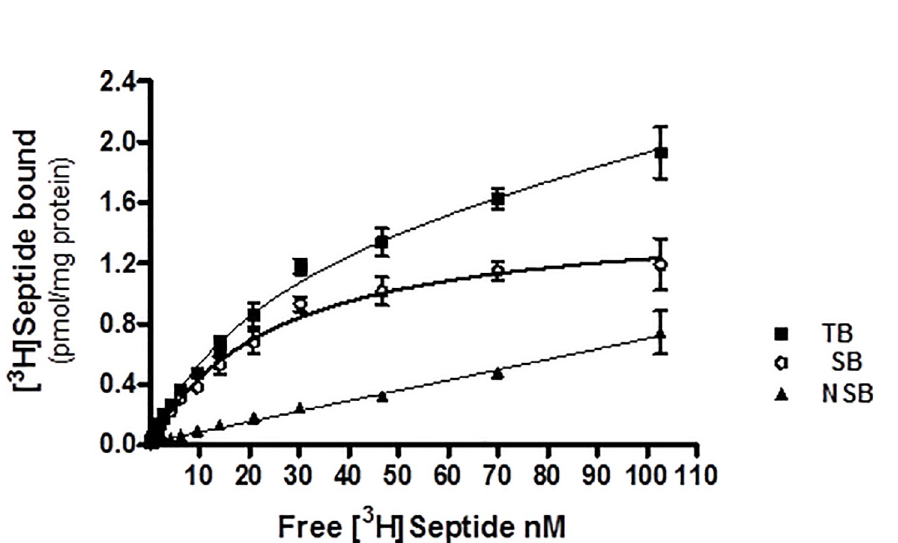
Fig 8. Saturation binding of [ 3 H]-Septide to human recombinant NK1 receptors. [ 3 H]-Septide binding to human NK1 receptors expressed in CHO membranes with increasing radioligand concentrations. Saturation data were subjected to nonlinear regression analysis. Values are means ± SD of triplicate determinations of TB and duplicates of NSB at each radioligand concentration. TB: total binding; SB: specific binding; NSB: nonspecific binding.